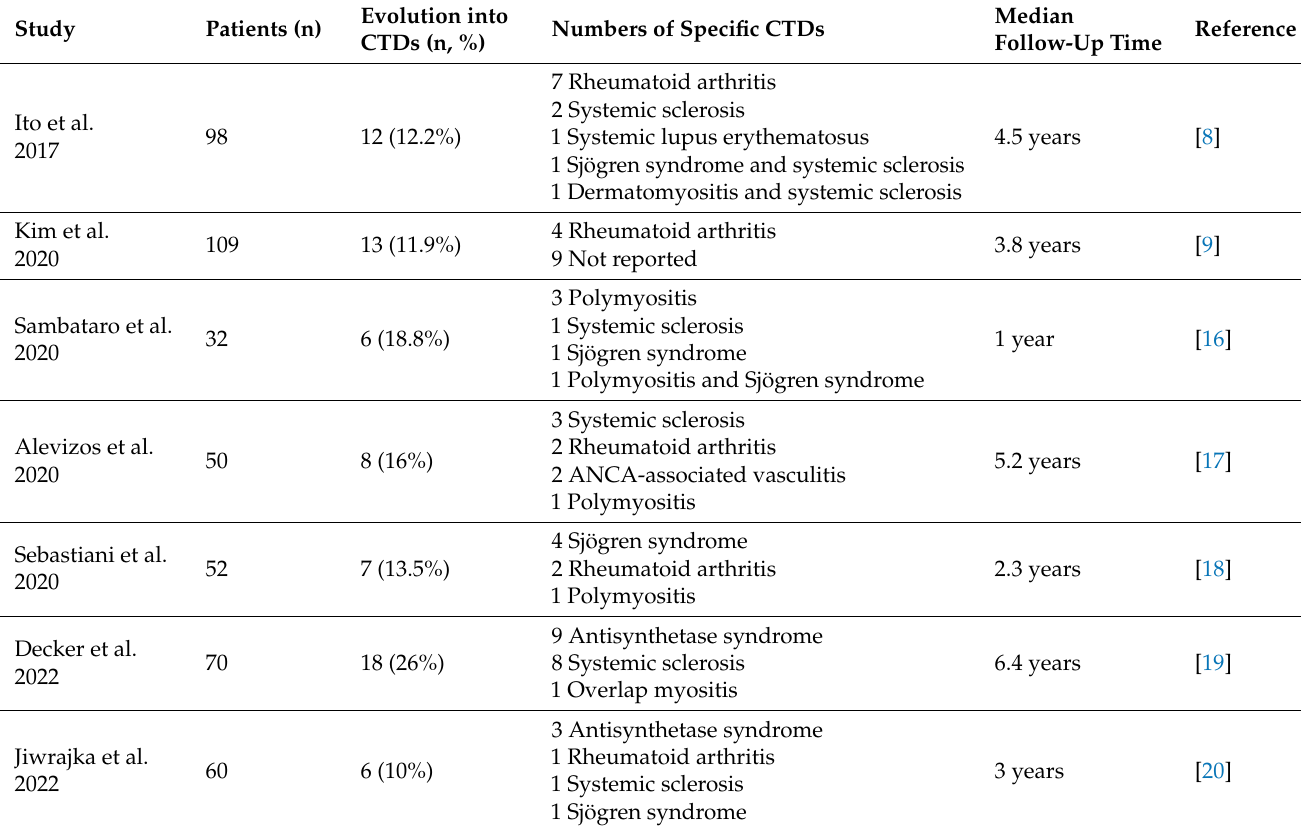
Table 1. Evolution into connective tissue diseases in patients with